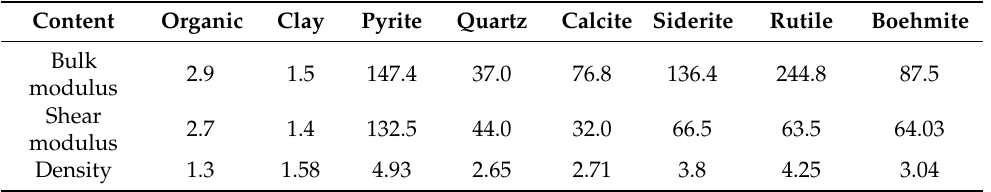
Table 5. Moduli (GPa) and densities (g/cc) of organic matter and minerals observed in No. 6 coal. Content